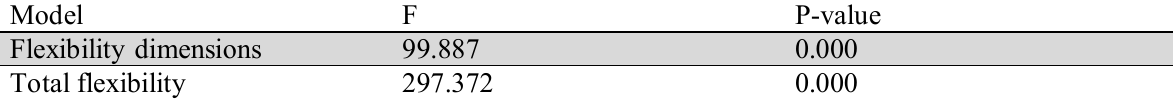
Model F Flexibility dimensions